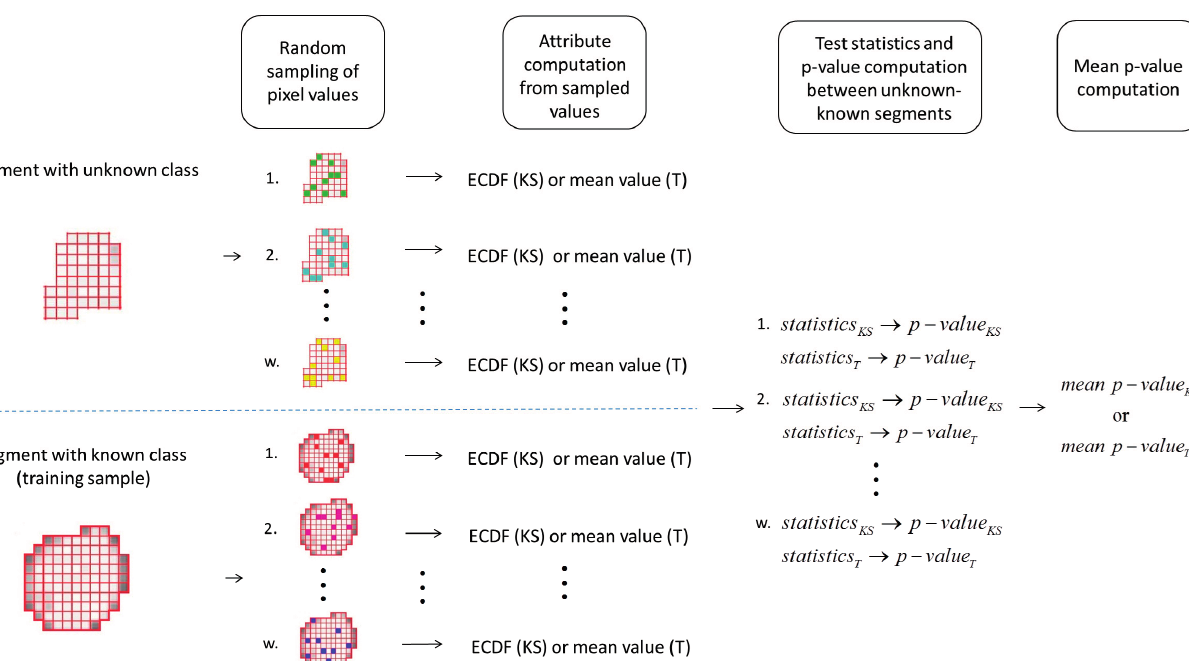
Figure 3. Random sampling approach. Empirical cumulative distribution functions and mean values are computed for each set of sampled pixel values for segments with a known and unknown class. A p -value between segments with an unknown and known class is computed after each sampling and averaged (mean p -value) in order to obtain a single value for the specific combination of the two segments. ECDF stands for empirical cumulative distribution function, KS for two-sample Kolmogorov-Smirnov test statistics and T for Student’s t -test